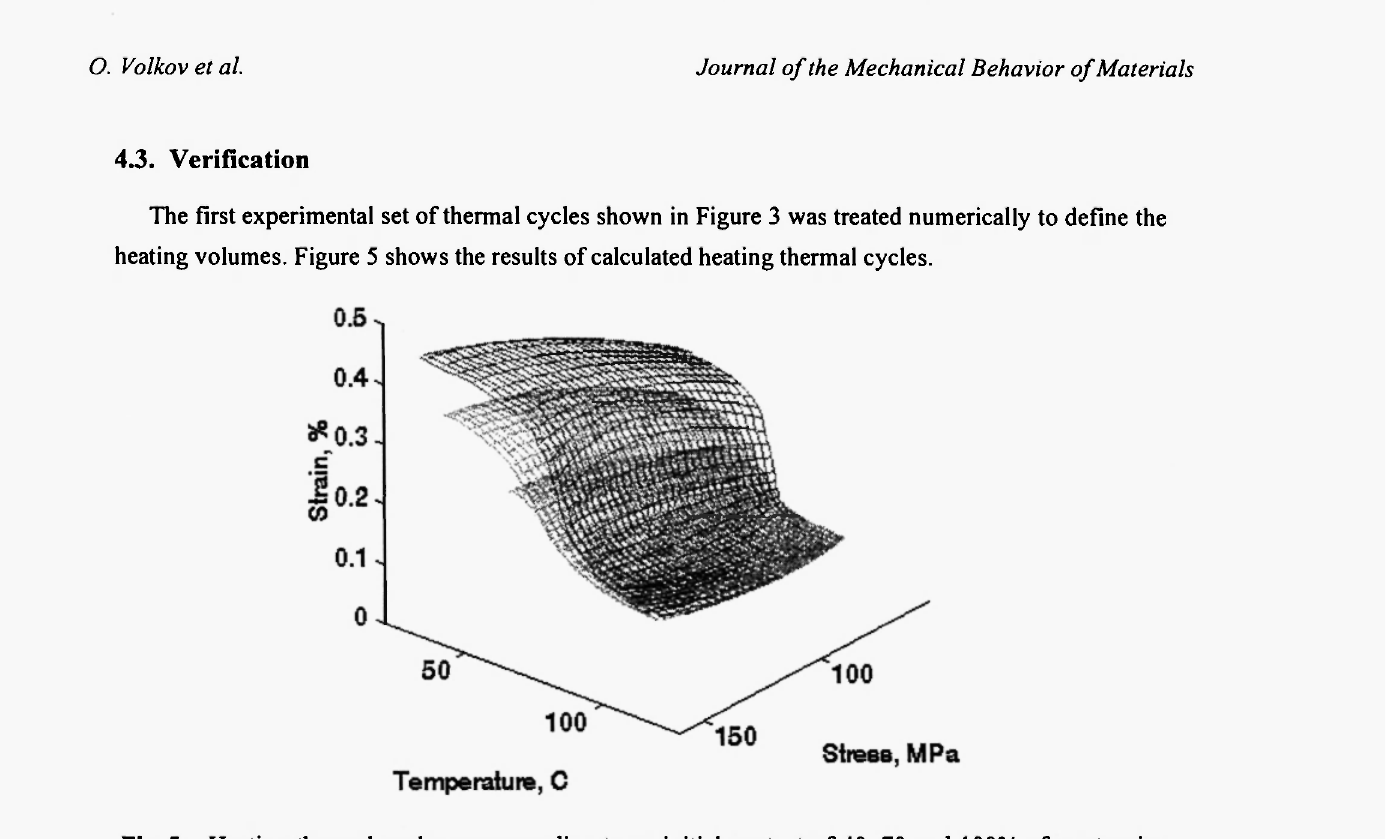
Fig. 5: Heating thermal cycles corresponding to an initial content of 40, 70 and 100% of martensite: the hysteretic volume is created using the three sampling sets of Figure 3 obtained for loads of 53, 107 and 160 MPa.